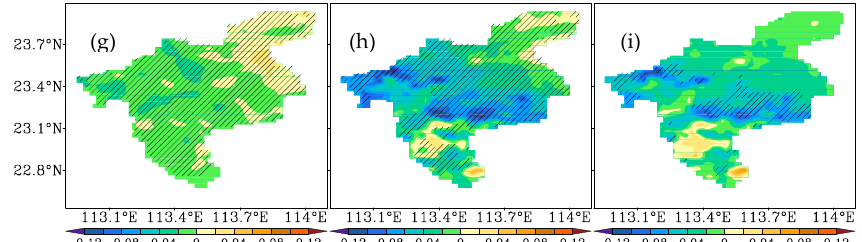
Figure 5. Trends in ( a , b ) T 4 and ( d , e ) T xn , and ( g , h ) the corresponding differences (T xn minus T 4 ) under ( a , d , g ) EX1 and ( b , e , h ) EX2 for 1980 and 2016. ( c , f ) The urban-related warming contributions for ( c ) T 4 and ( f ) T xn , and ( i ) the corresponding differences over Guangzhou (oblique line denotes passing the 90% confidence level significance t -tests, units: °C/decade).